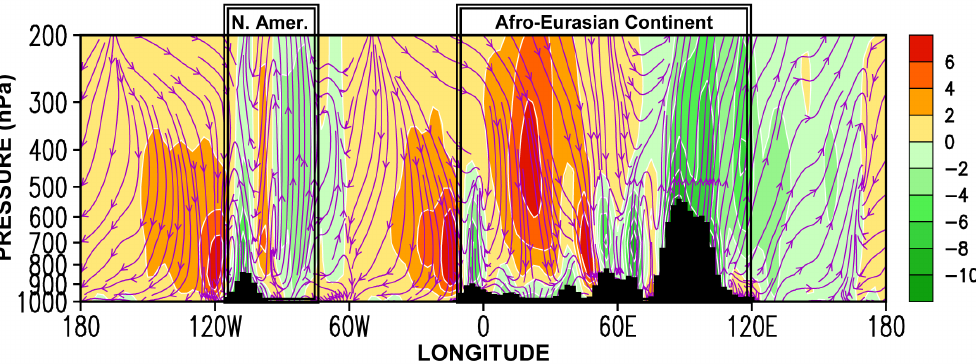
Fig. 3. July mean vertical cross-section of subtropical circulation along 30 ◦ N (vertical velocity has been amplified by a factor of 100). The boxes indicate the locations of the North American and Afro-Eurasian continents. Black shading indicates orography, and color shading indicates the intensity of the vertical p-velocity ω (interval, 2Pas − 1 ) , as shown in the color scale to the